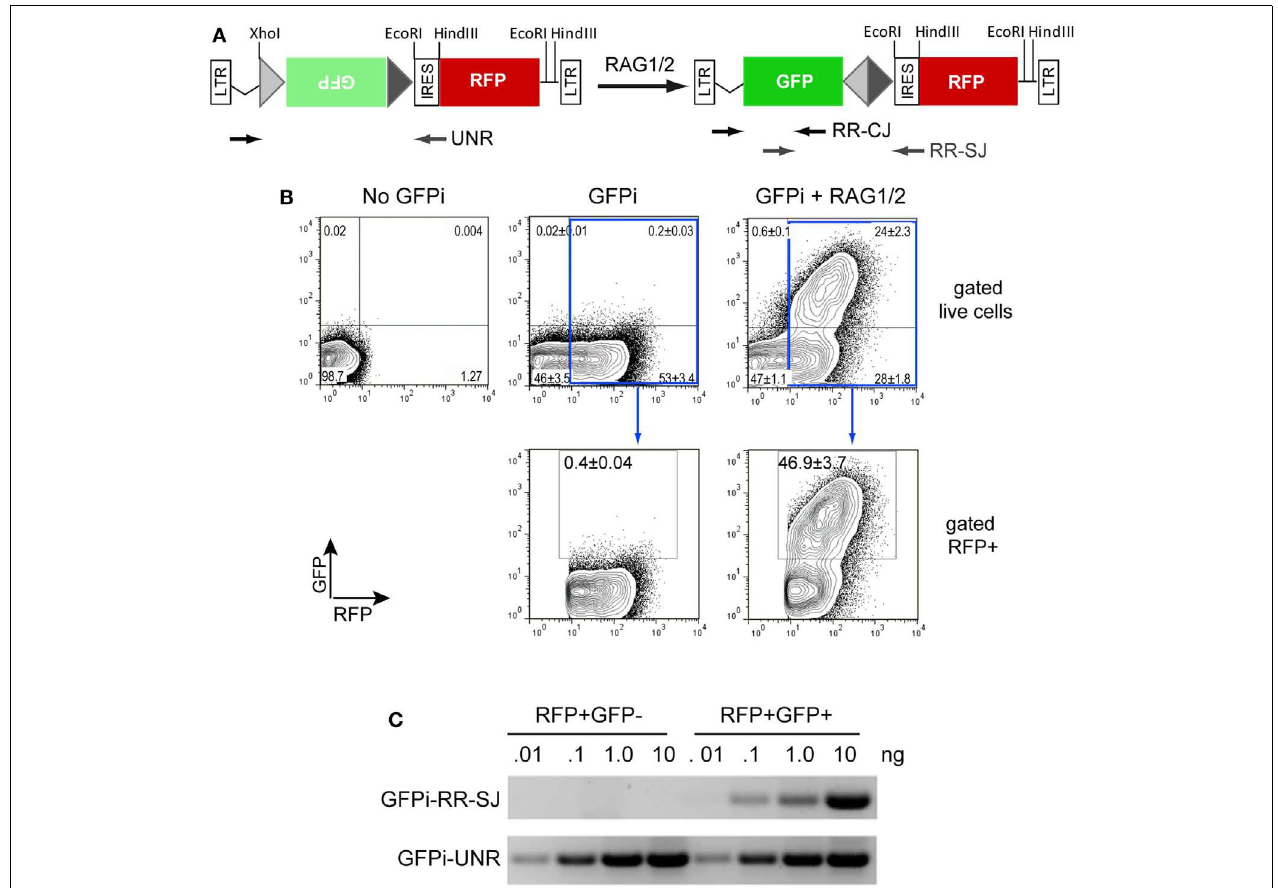
FIGURE 2 |The GFPi reporter . (A) Linear representation of the GFPi reporter (left) and resulting structure following RAG activity (right); GFPi is constructed from a murine stem cell virus (MSCV) retroviral vector and the portion flanked by the long-terminal repeats (LTRs) is represented. From the 5 (cid:48) to the 3 (cid:48) LTR, the relevant segments are as follow: a 12-spacer RSS (light gray triangle), the GFP inverted complementary sequence (green box), a 23-spacer RSS (dark gray triangle), an internal ribosomal entry site (IRES), the RFP coding sequence (red box). Upon RAG-mediated GFP inversion formation of a coding joint (CJ) and signal joint (SJ) is indicated.The arrows represent the primers used to detect GFPi unrearranged (UNR) and rearranged (RR) CJ and SJ in (C) . (B) GFP/RFP flow cytometry contour plot analysis of a